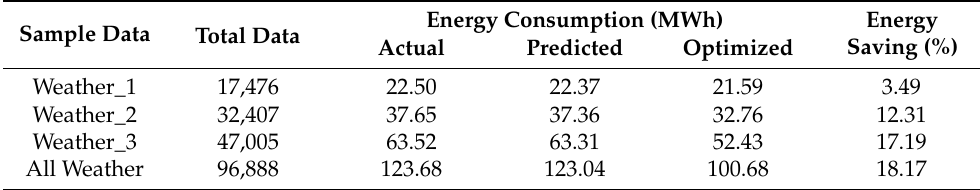
Table 2. Simulation optimization results.